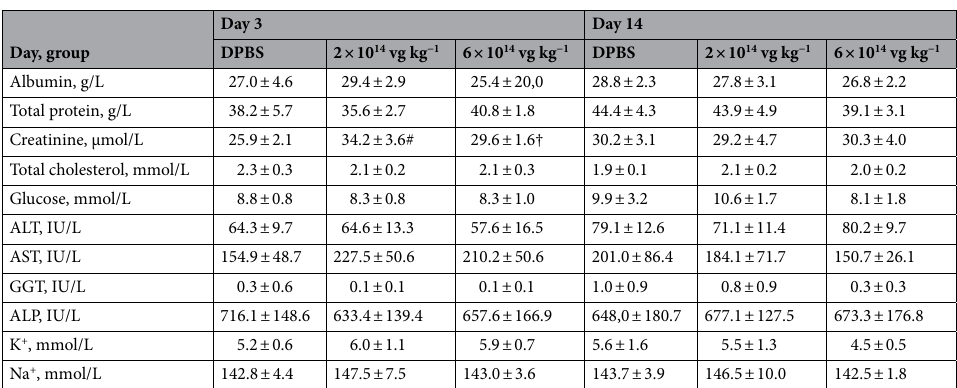
Table 1. Results of blood biochemical test in rats on days 3 and 14 after a single intravenous injection of rAAV9-Hco-µUtrn-FLAG. All data are presented as mean ± SD. # P = 0.0007 when compared to the control group (DPBS, day 3). † P = 0.0380 when compared to the group treated with a low dose of rAAV9-Hco-µUtrn- FLAG (2 × 10 14 vg kg −1 , day 3). In both cases (# and †), statistical analysis was performed via ANOVA and Tukey’s post-hoc